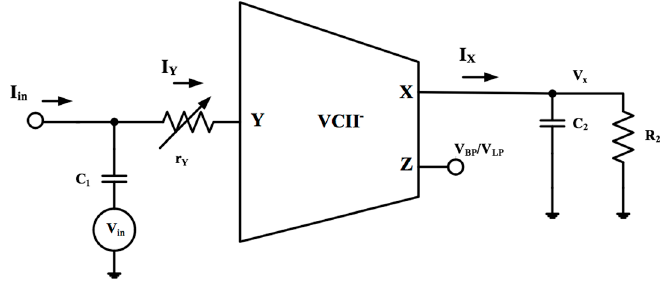
Figure 2. The proposed VCII - -based second-order LP/ BP filter realization.